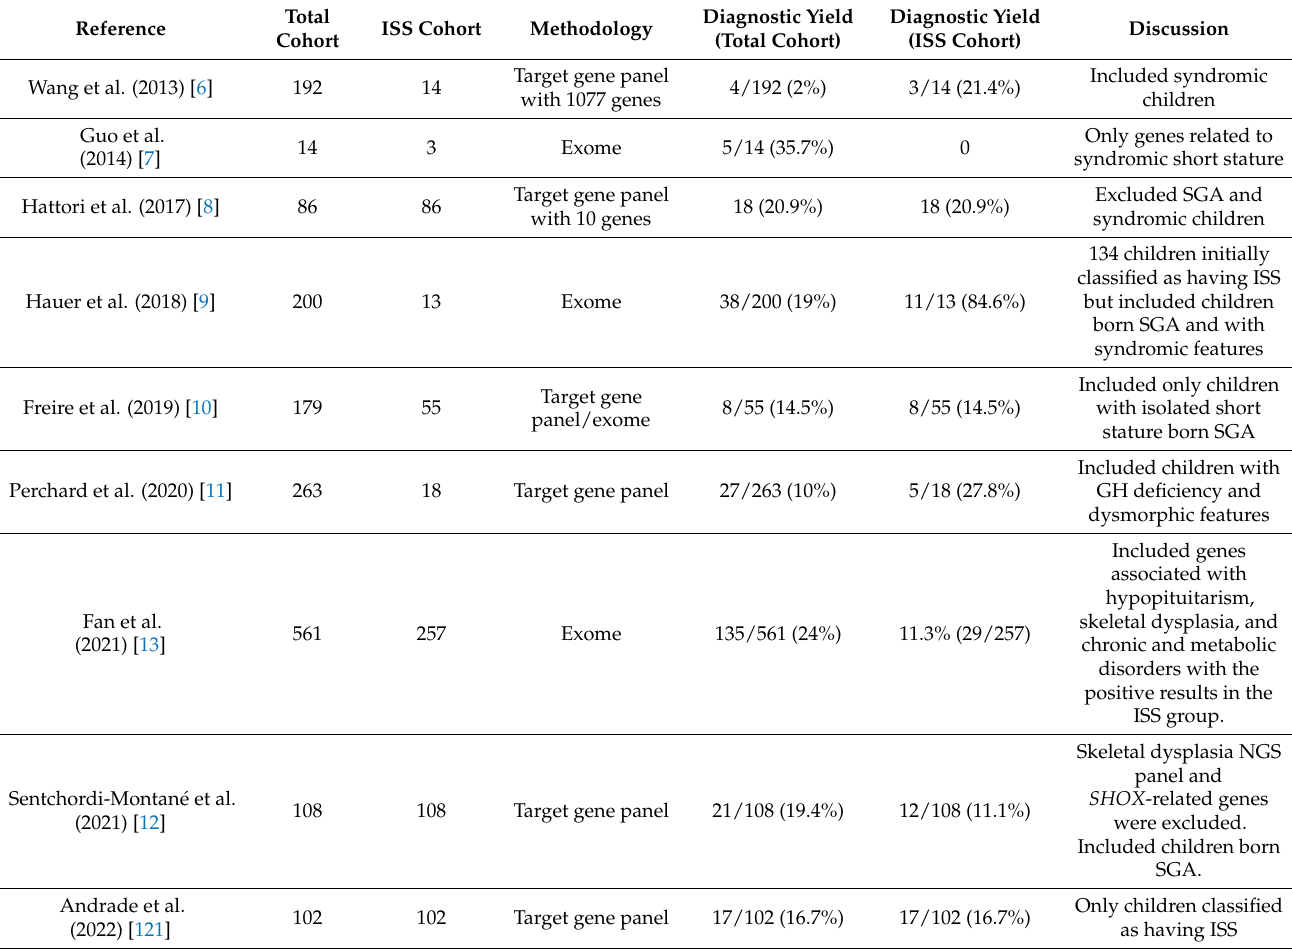
Table 2. A review of multigene approach studies on “idiopathic short